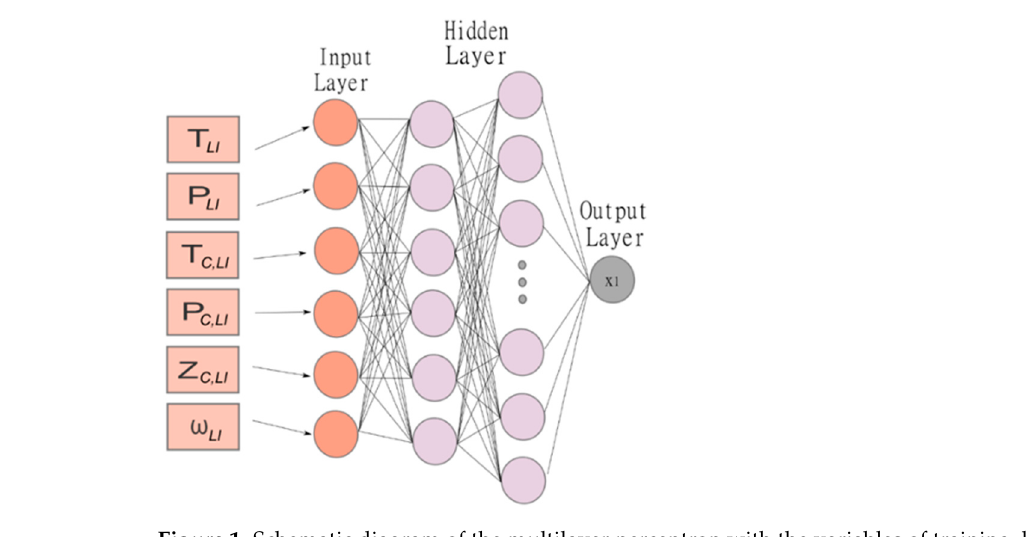
Figure 1. Schematic diagram of the multilayer perceptron with the variables of training, hidden, and output layers used in this study.